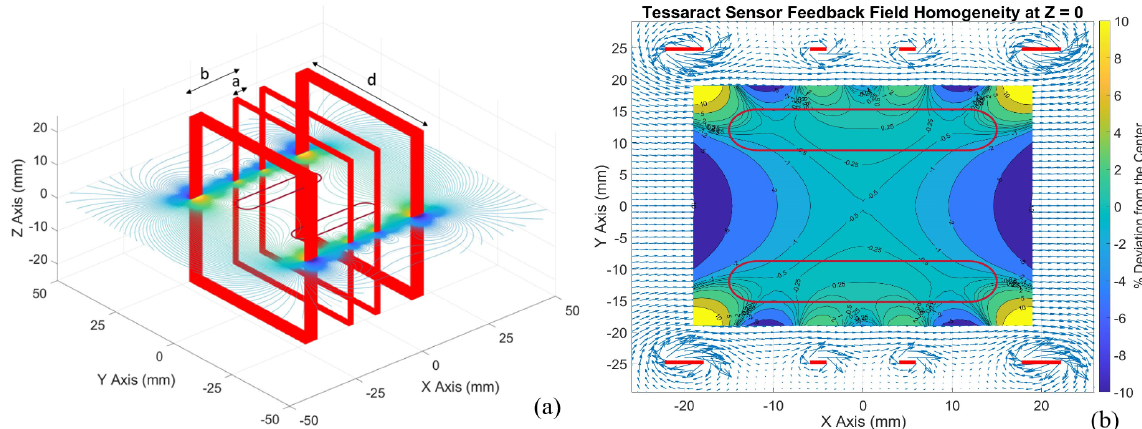
Figure 4. (a) A four-square Merritt coil system is the basis of the design for the Tesseract sensor’s feedback windings. A Biot–Savart simulation of Tesseract’s feedback winding models each loop of wire as a square array assigned a position on a 3D grid. Here we show a rendering of the x axis feedback coil. (b) A 2D cross section at z = 0 of the Biot–Savart model of the Tesseract sensor. The maroon loops outline the regions where the racetrack sensors are situated. The contours plot the percentage of deviation of the field from its average along the axis of the racetrack cores ( y = + 12mm, − 12mm). In this region, the maximum deviation of the magnetic field from the average field along the racetrack core is about 0.42%. Blue arrows map out the direction and magnitude of the B field, while the red dots represent the positions of the wires.